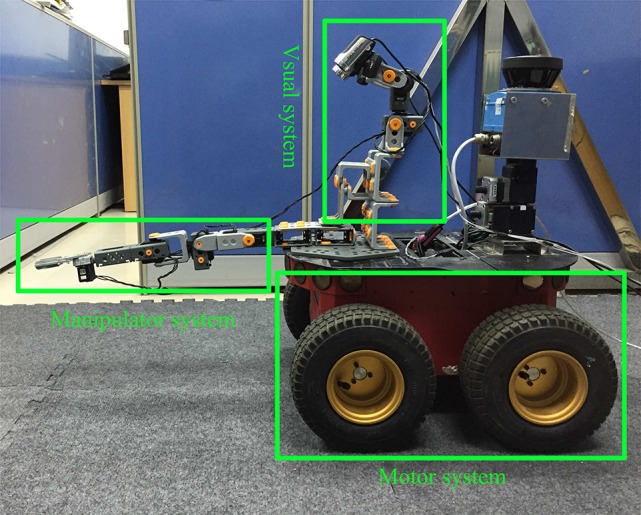
The robotic hardware.